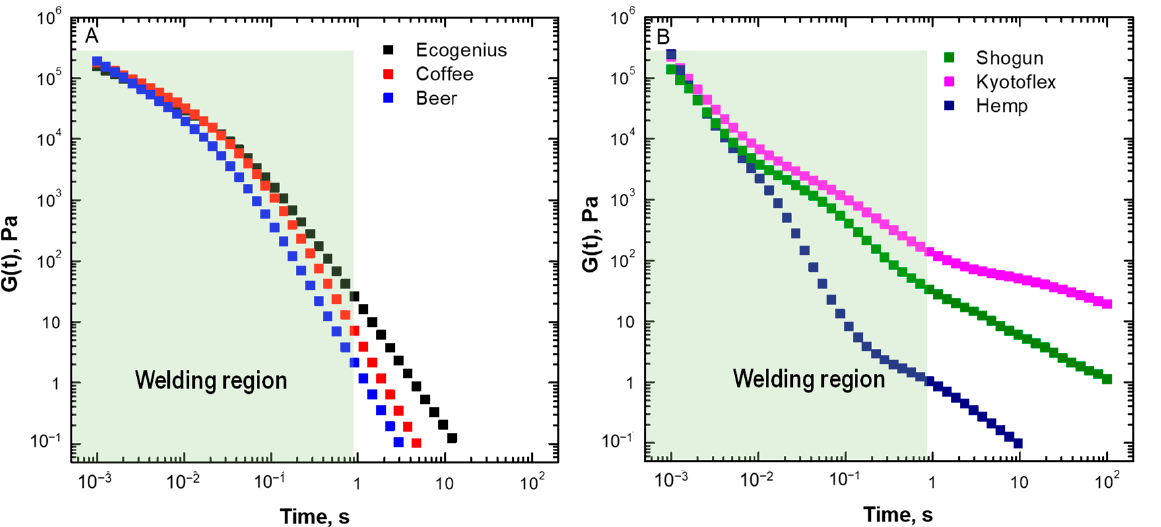
Figure 7. Stress relaxation modulus as a function of time for PLA-based materials showing ( A ) complete, and ( B ) incomplete relaxation. The green area highlights the region in which (according to the Dahlquist criterion) interlayer bonding is expected.